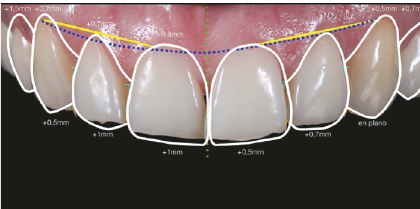
Figure 6: Orientation grooves for the vestibular reduction.